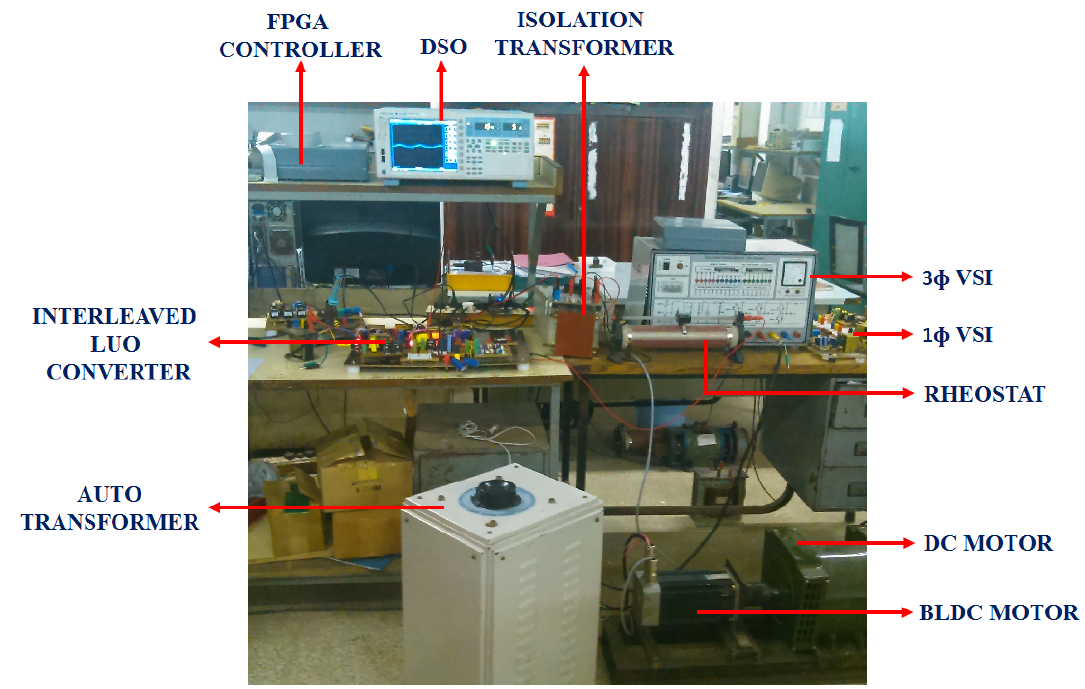
Figure 11. The experimental setup of the proposed system.